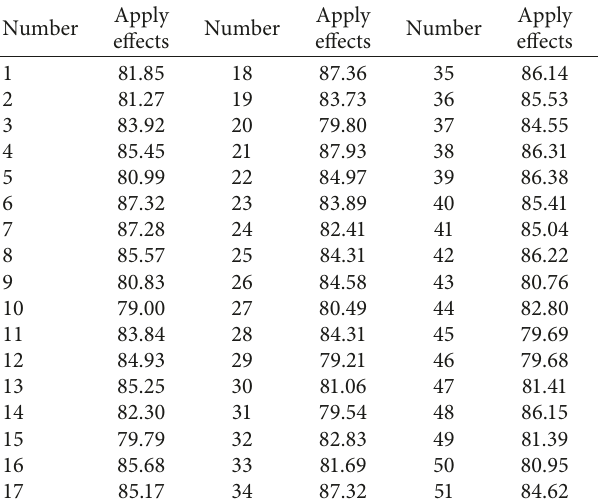
Table 1: The application effect of the speech interaction system model based on semantic search in the English MOOC teaching